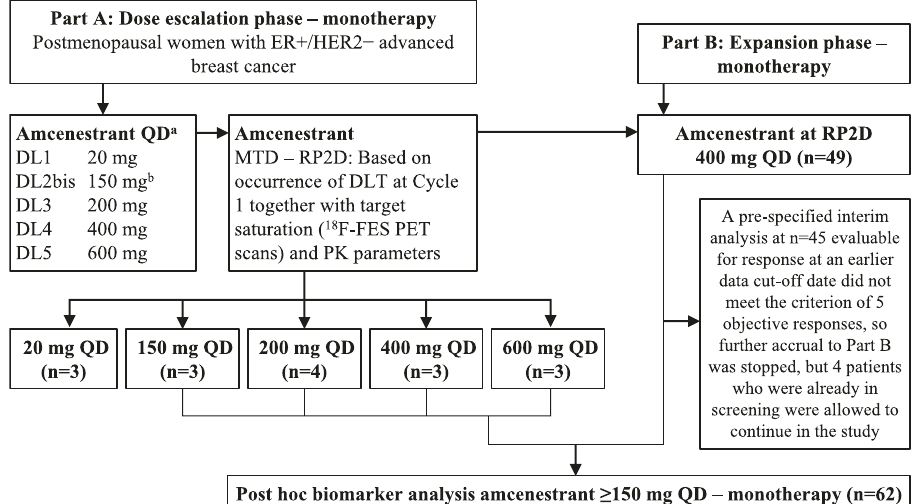
Fig. 1 Study fl ow diagram for Parts A and B. During Part A, patients were enrolled into a dose escalation phase of amcenestrant monotherapy from 20- 600 mg once daily. During Part B, patients were enrolled into a dose-expansion phase at the RP2D determined in Part A. a The fi rst patient treated at each new DL will be followed for a minimum of 1 week prior to enrolling and treating two additional patients. If none of the three patients experience a DLT, the next cohort starts one DL higher. If one of the three patients experiences a DLT, up to three additional patients are treated at this DL. If two or more patients experience a DLT, the maximum administered dose is reached. b DL2bis is investigated if at least one patient at DL1 shows ≤ 30% inhibition of the target by 18 F-FES PET or all patients treated at DL2 have >85% inhibition of the target by 18 F-FES PET. DL dose level, DLT dose-limiting toxicity, ER + estrogen receptor positive, 18 F-FES PET 18 F- fl uoroestradiol positron emission tomography, HER2 − human epidermal growth factor receptor 2-negative,